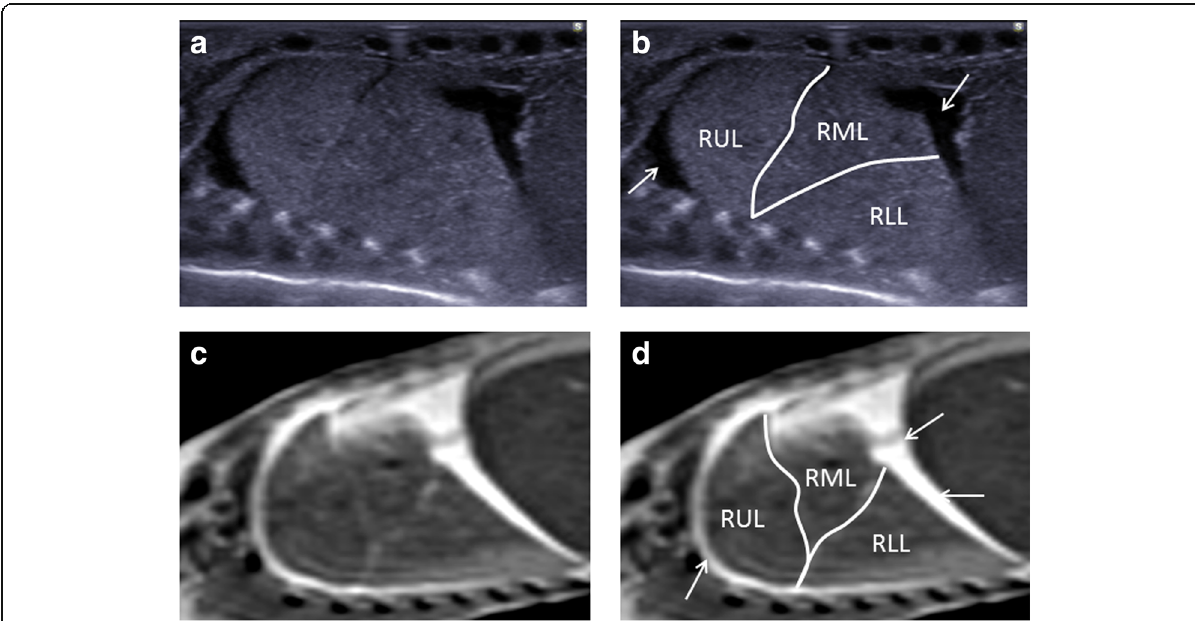
Fig. 7 Paired sagittal postmortem ultrasound ( a , b ) and T2-weighted postmortem MRI images at 1.5 T ( c , d ) of the right lung in the same 18- week gestational-aged foetus, 12 days after death. These images clearly demonstrate the three different pulmonary lobes (RUL — right upper lobe, RML — right middle lobe, RLL — right lower lobe). The solid white arrows on the labelled images show normal expected physiological pleural fluid seen as part of postmortem change and should not be described as